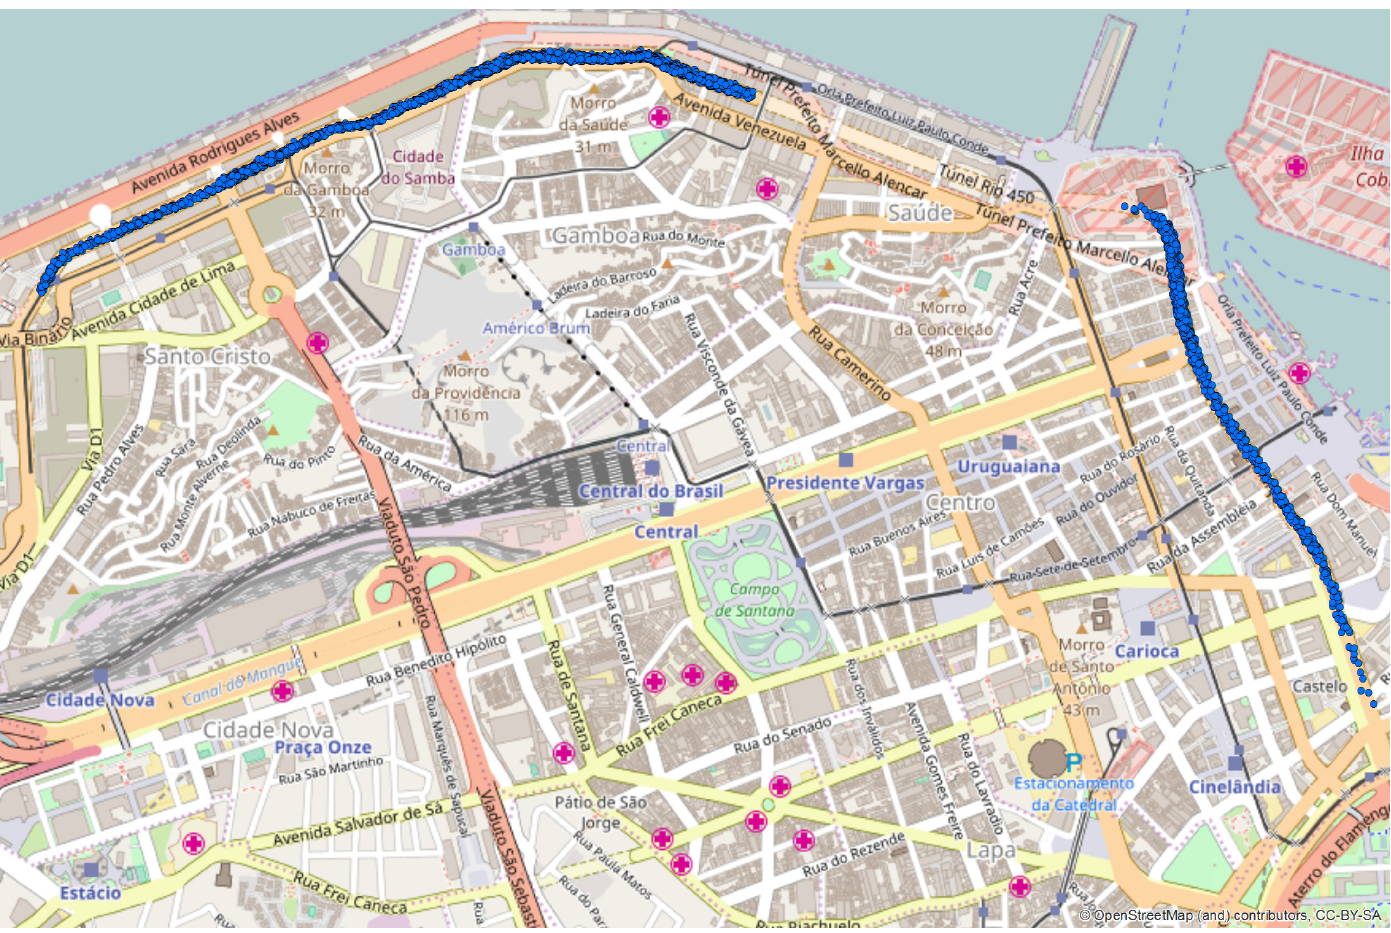
Figure A3. Rio 450 Tunnel, Rio de Janeiro